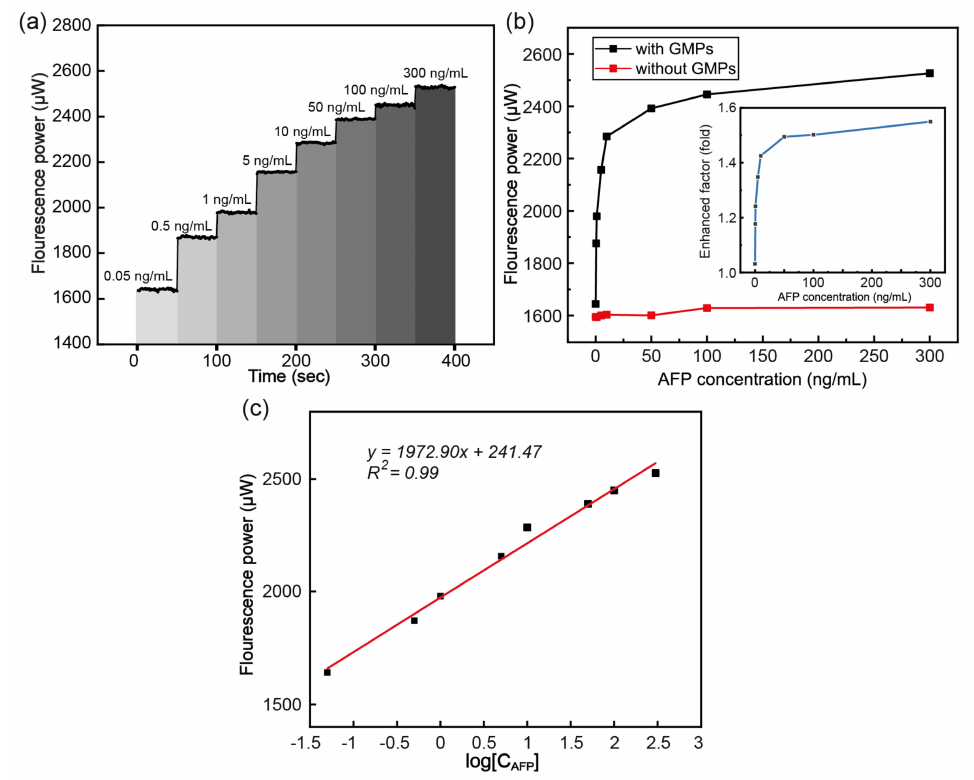
Figure 8. ( a ) The fluorescence power measurement while increasing the AFP concentration (0.05–300 ng/mL) over time. ( b ) The fluorescence signals obtained with the chamber surface, where the GMPs were coated (black) or not (red), and their corresponding EF values (blue). ( c ) The linear fitting of the fluorescence power versus the logarithm of the AFP concentration in the range of 0.05–300